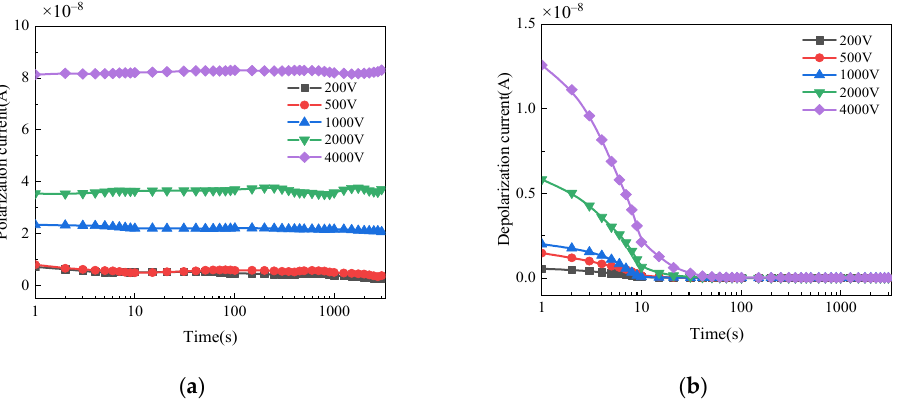
Figure 7. Polarization/depolarization current of normal bushing: ( a ) Polarization current; ( b ) Depo- larization current.